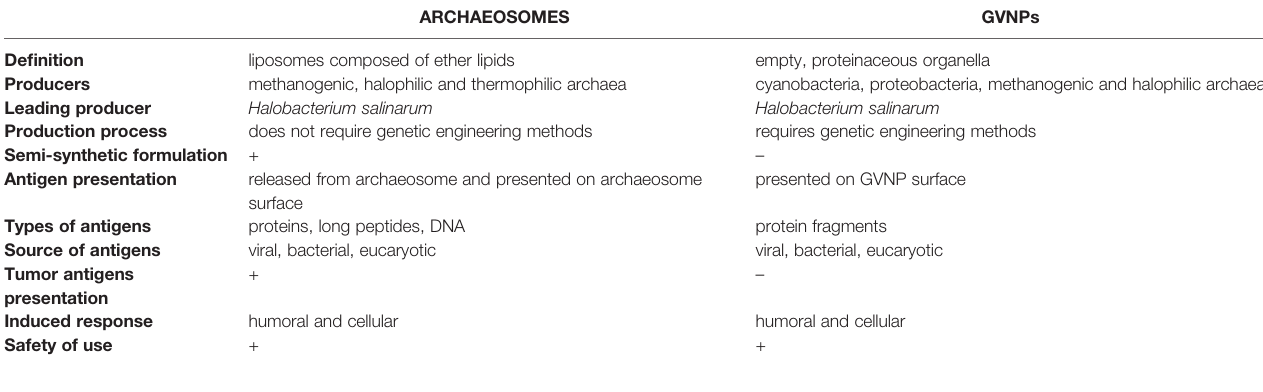
TABLE 2 | Comparison of archaeosomes and gas vesicle characteristics.